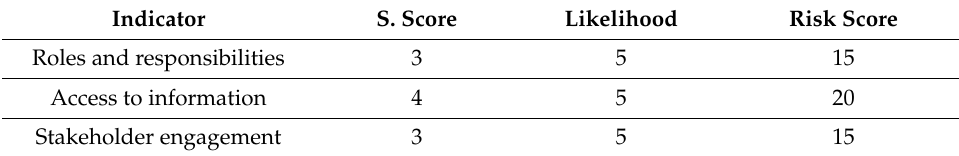
Table 22. Security and likelihood scores for roles and responsibilities (RR), access to water information (AWI) and stakeholder engagement (SE) indicators.